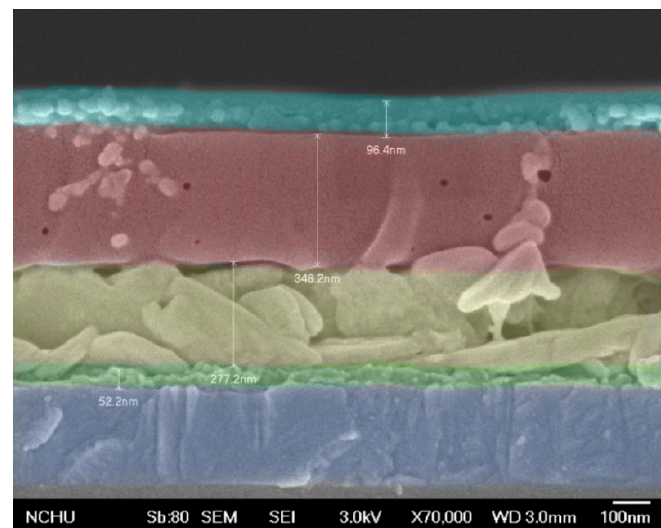
Figure 1. Cross-sectional SEM image of a typical perovskite cell fabricated in this study.